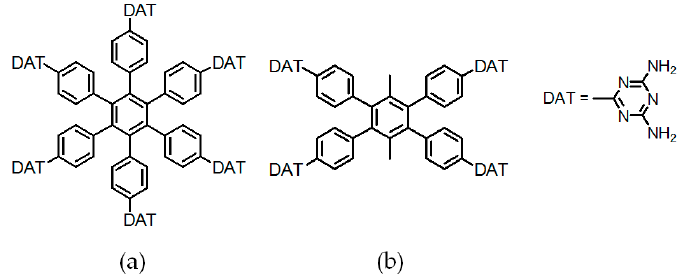
Figure 27. Structures of building motifs 30a (Figure 27 a ), 30b (Figure 27 b ). Figure 28. Structures of building motifs 30a (Figure 28 a ), 30b (Figure 28 b ). Figure 28. Top views of porous H30a ( a ) and H30b ( b ) grown from DMSO/THF and DMSO/dioxane.